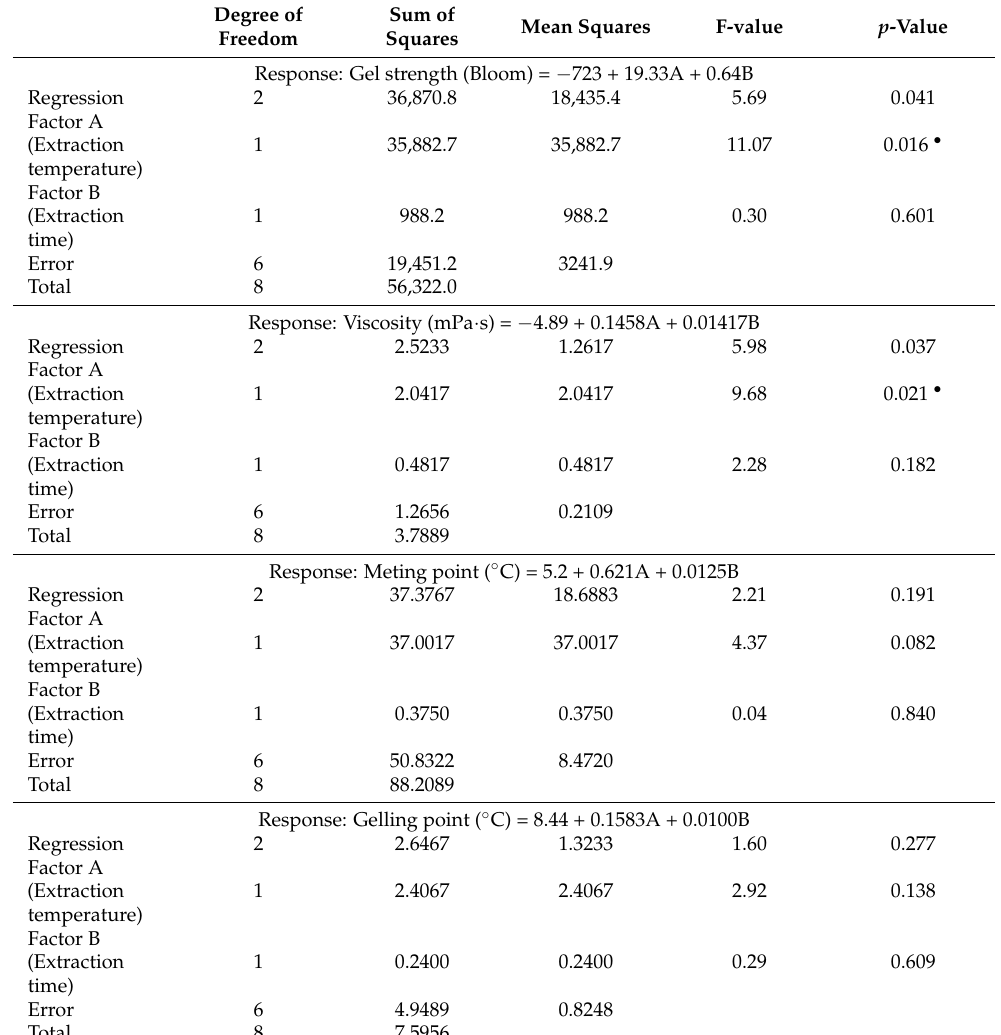
Table 5. Analysis of variance of the experimental design for gelatin gel strength, gelatin viscosity, melting point, and gelling